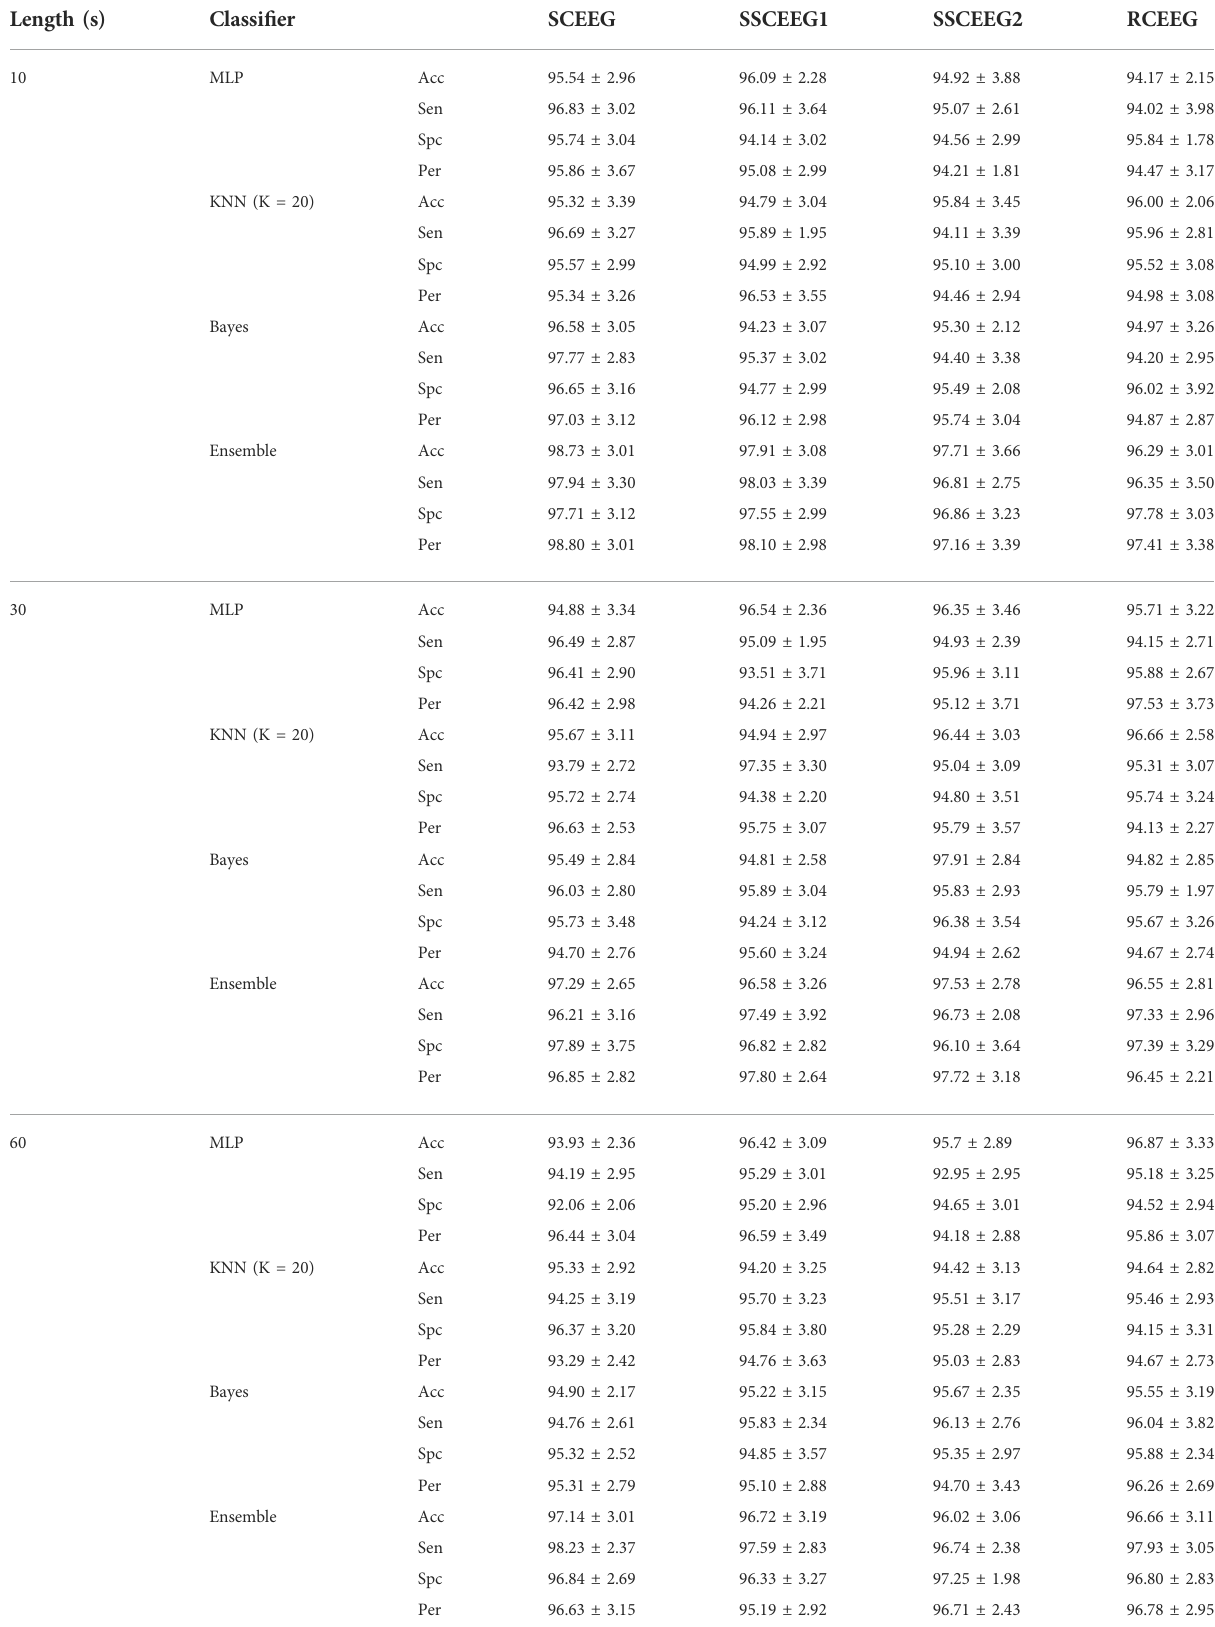
TABLE4Classi fi cationresults(inthe2-classscenario) forrecognizingneuralandartifactualcomponents.Acc,Sen,SpcandPerpresentclassi fi cation accuracy, sensitivity, speci fi city and precision, respectively. Ensemble represents the mixture of classi fi ers. Length